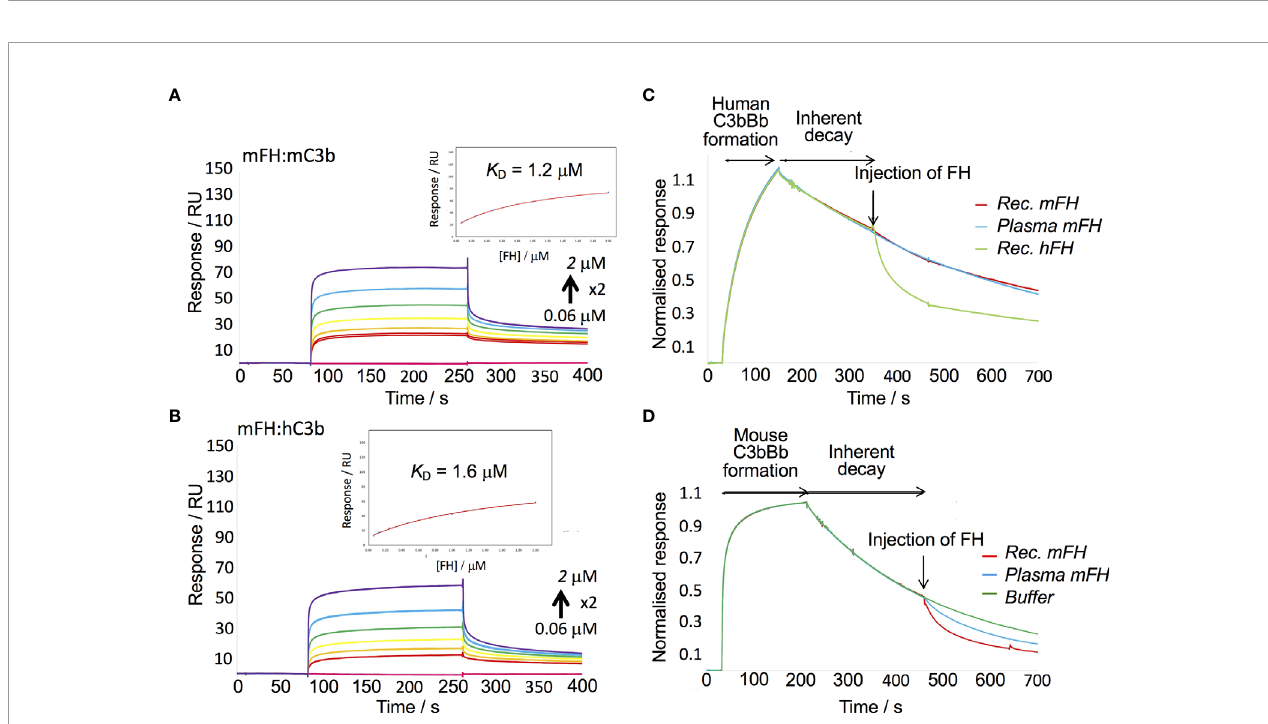
FIGURE 3 | In vitro assays of recombinant mFH. (A) A recombinant mFH dilution series was fl owed over murine C3b amine-coupled to a C1 chip [233 response units (RU)] in the SPR instrument, and equilibrium data plotted (insert). (B) The recombinant mFH was fl owed over human C3b (258 RU), as in (A) K D estimates in (A, B) assumed reversible 1:1 binding. (C) In a decay-acceleration assay, human C3b was coupled to a CM5 chip (1140 RU) then human FB and FD were fl owed over it, forming human C3bBb. Its decay rate accelerated upon injection (arrow) of 100 nm hFH. No such increase was elicited by recombinant mFH, or FH from mouse serum. (D) Murine C3b was amine coupled to the CM5 chip (1510 RUs), then mouse FB and FD were injected, forming mouse C3bBb. Its decay rate was increased following injection of 40 nM mFH.